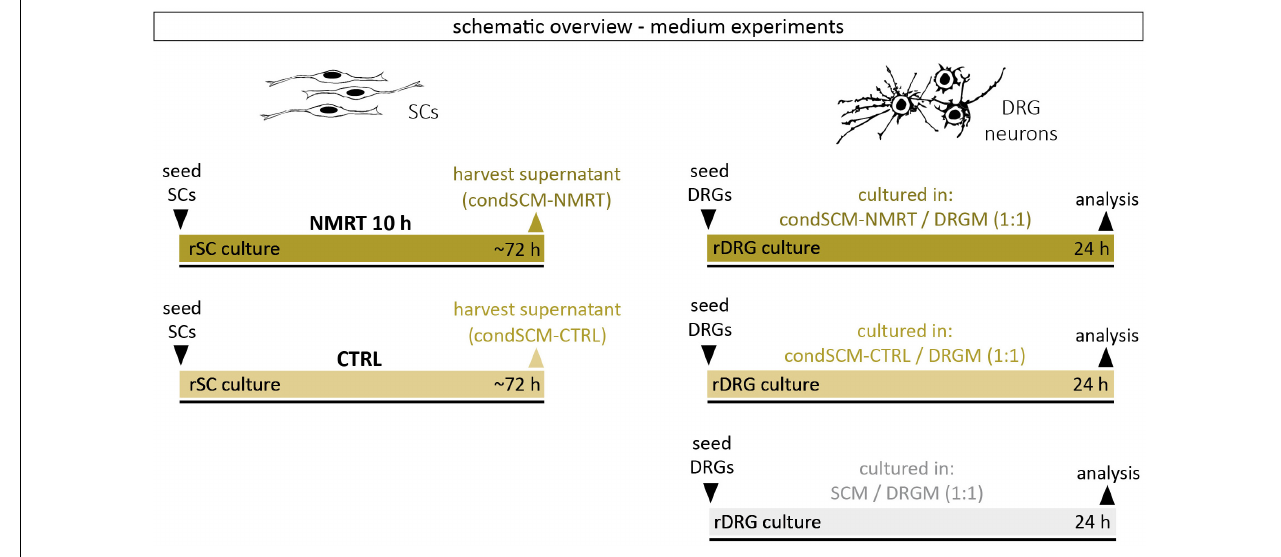
values for statistical analysis is shown in Supplementary Figure 1 . The results are depicted as single values for each donor ± standard deviation (SD); ∗ p < 0.05, ∗∗ p < 0.01, ∗∗∗ p <